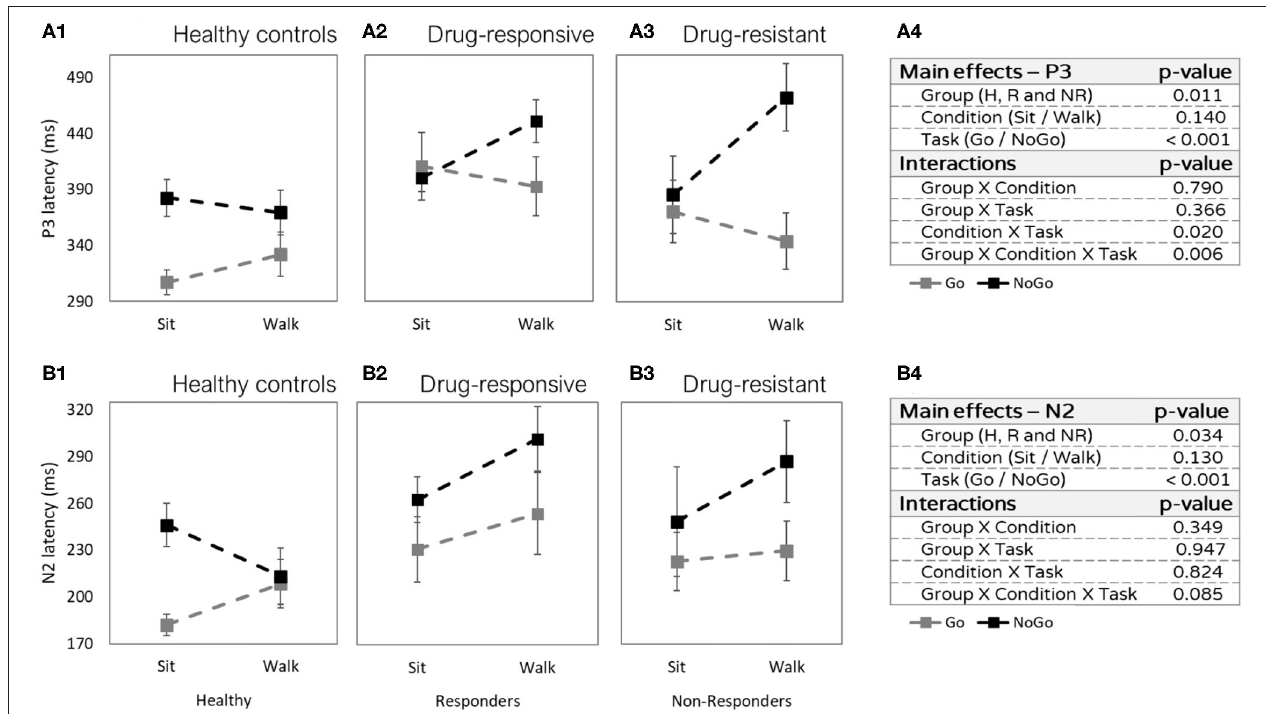
FIGURE 4 | Latencies differences (in milliseconds) between sitting and walking (Y axis), in the Go task (gray) and in the NoGo task (black). (A1) P3 latencies of healthy controls. (A2) P3 latencies of people with drug-responsive JME. (A3) P3 latencies of people with drug-resistant JME. (A4) P3 effects and interactions summery. (B1) N2 latencies of healthy controls. (B2) N2 latencies of people with drug-responsive JME. (B3) N2 latencies of people with drug-resistant JME. (B4) N2 effects and interactions